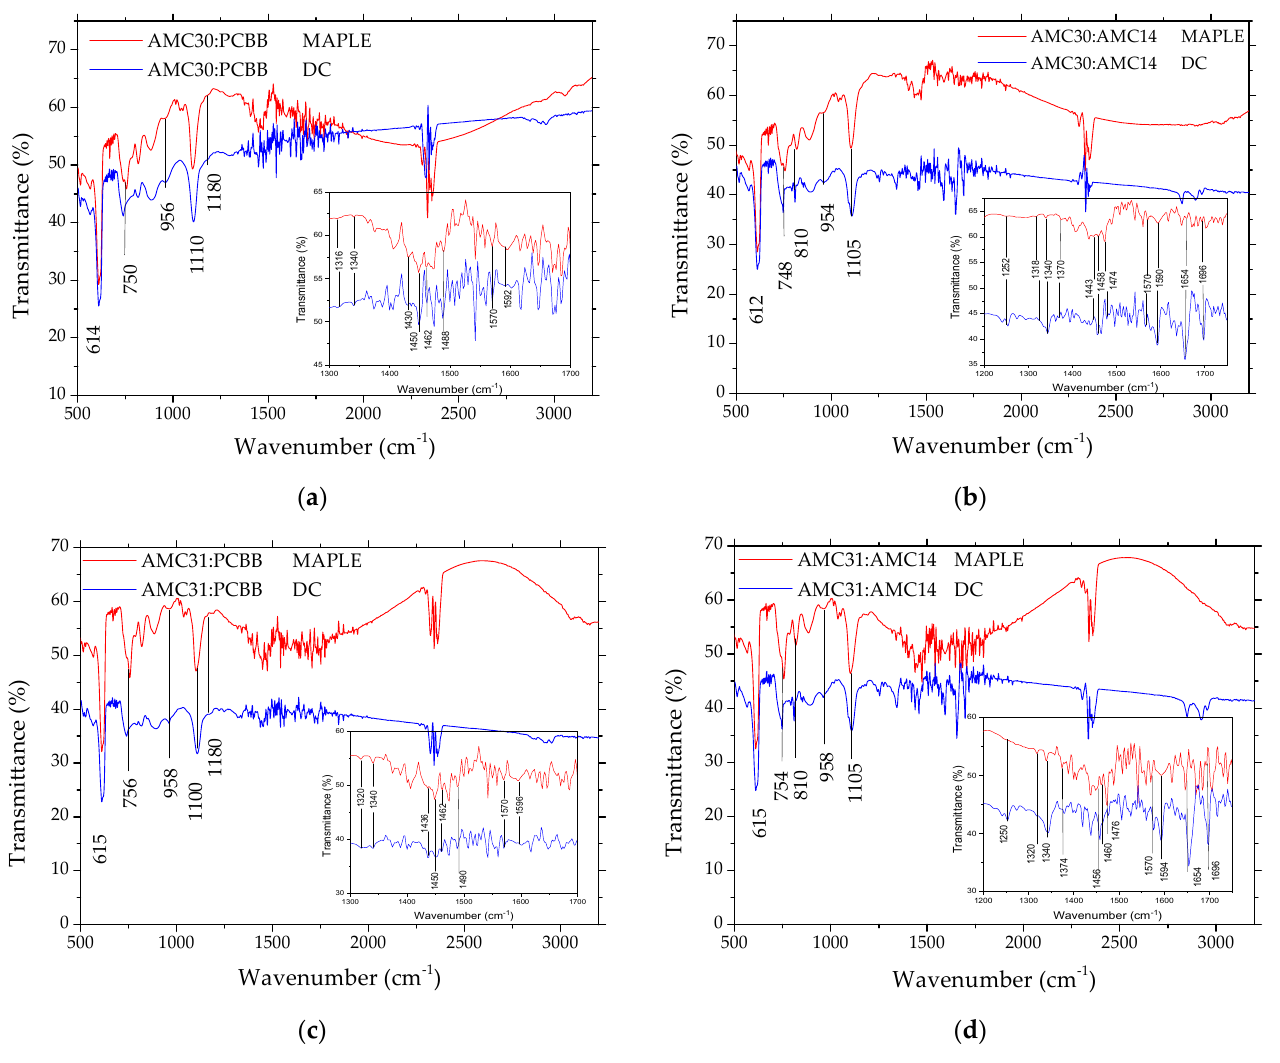
Figure 6. FTIR spectra of the MAPLE mixed layers by comparison with the drop cast mixed layers deposited on Si from the same solvent, 1,2 dichlorobenzene: AMC30:PCBB ( a ); AMC30:AMC14 ( b ); AMC31:PCBB ( c ); AMC31+AMC14 ( d ). The insets present the details of the FTIR spectra for AMC30/AMC31:PCBB in the spectral range 1300–1700 cm −1 ( a , c ) and AMC30/AMC31:AMC14 in the spectral range 1200–1750 cm − 1 ( b , d